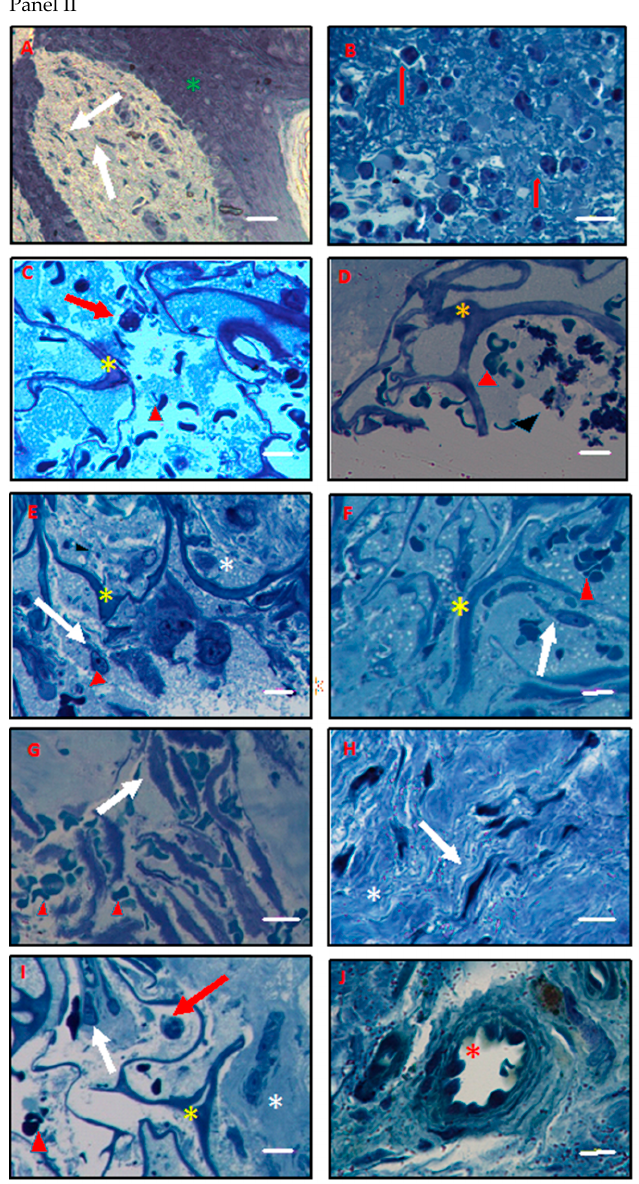
Figure 7. Histological features of tissue biopsies withdrawn at time point 0 and at different post- surgical time points after IDRT or IFWM application. Panel I : ( A , B ) Representative histological images of tissue biopsies withdrawn at time point 0 in a healthy part of the skin ( A ) or in the lesion ( B ); ( C – J ) representative images of the histological appearance of tissue biopsies withdrawn: Seven ( C , D ), 14 ( E , F ), 21 ( G , H ) and 28 ( I , J ) days after IDRT application. Panel II : ( A , B ) Representative histological images of tissue biopsies withdrawn at time point 0 in a healthy part of the skin ( A ) or in the lesion ( B ); ( C – J ) representative images of the histological appearance of tissue biopsies withdrawn: Seven ( C , D ), 14 ( E , F ), 21 ( G , H ) and 28 ( I , J ) days after IFWM application. The left images represent the lower degree of wound healing that we observed for each time point, whereas the right images represent the higher degree of wound healing that we observed for each time points. Green asterisk indicates epidermis, white arrows indicate fibroblasts; red arrows indicate leukocytes; yellow arrow indicates vacuolated somatic cells; red arrowhead indicates erythrocyte; black arrowhead indicates cellular debris; yellow asterisk indicates IDRT, white asterisks indicate extracellular matrix fibres, red asterisks indicate blood vessels. Scale bar = 10 µ